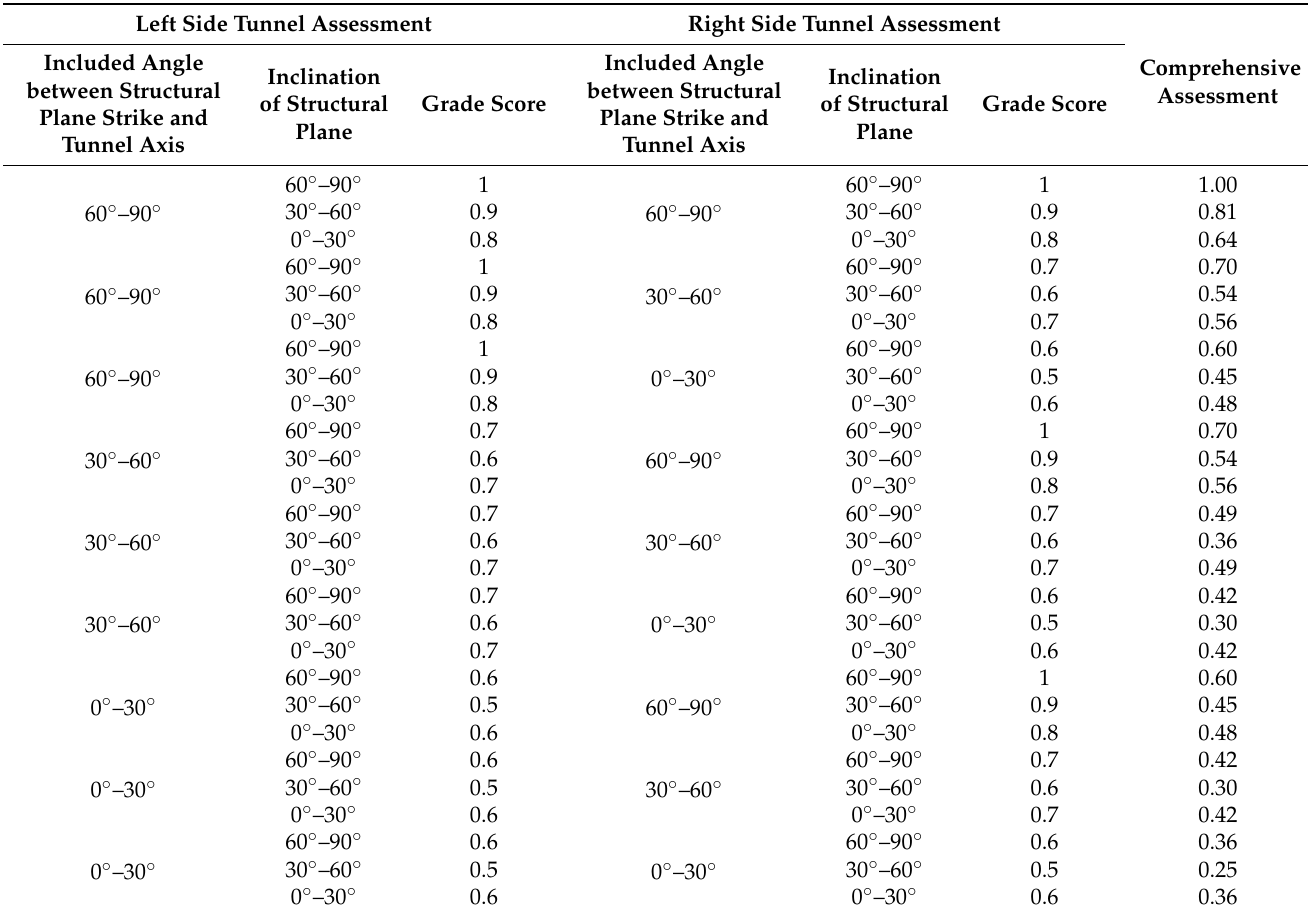
Table 3. Combination relationship between the orientation of the main structural plane and the axis of two adjacent